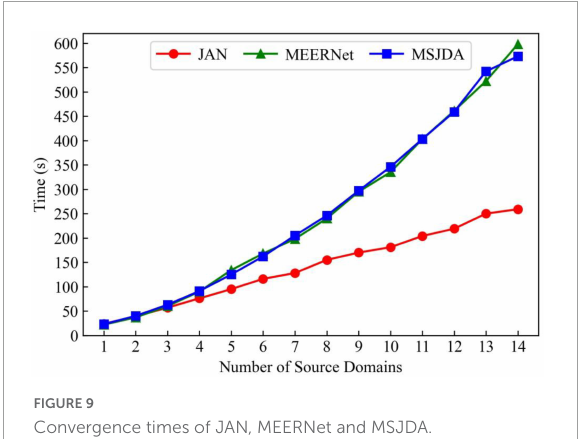
FIGURE9 Convergence times of JAN, MEERNet and MSJDA.